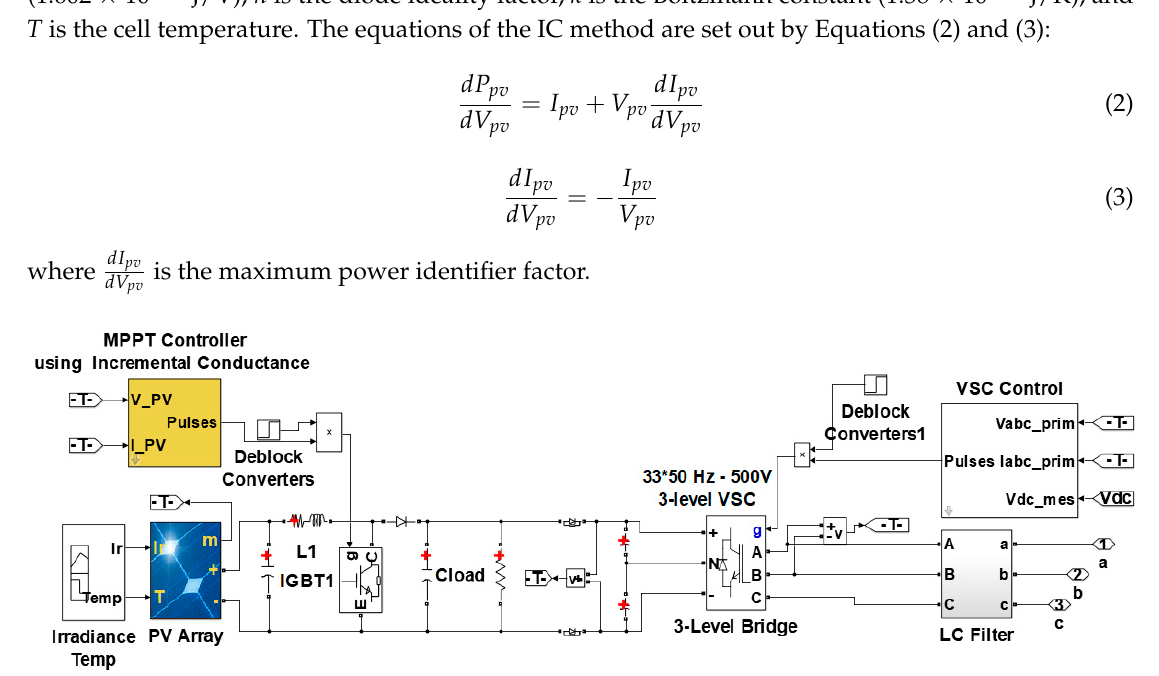
Figure 4. Solar PV model in Simulink.